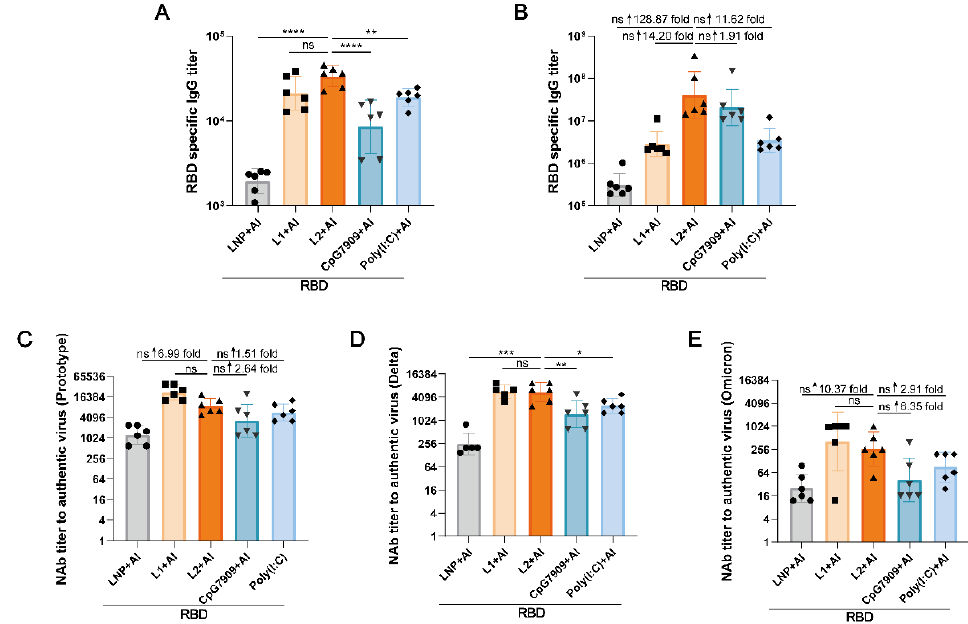
Figure 6. L2 + Al improved the immunogenicity of the RBD compared with CpG 7909 + Al and Poly(I:C) + Al. ( A , B ) RBD-specific IgG titers in RBD + LNP + Al, RBD + L1 + Al, RBD + L2 + Al, RBD + CpG7909 + Al, and RBD + Poly(I:C) + Al groups at 14 days after the 1st immunization and at 14 days after the 2nd immunization. ( A ) At 14 days after the 1st immunization. ( B ) At 14 days after the 2nd immunization. ( C – E ) NAb titers to authentic prototype, Delta and Omicron, variants in RBD + Al, RBD + L1 + Al, RBD + L2 + Al, RBD + CpG7909 + Al, and RBD + Poly(I:C) + Al groups at 14 days after the 2nd immunization. ( C ) Prototype. ( D ) Delta variant. ( E ) Omicron variant. * p < 0.05. ** p < 0.01. *** p < 0.001. **** p < 0.0001. ↑ , increase. n = 6 for each group.